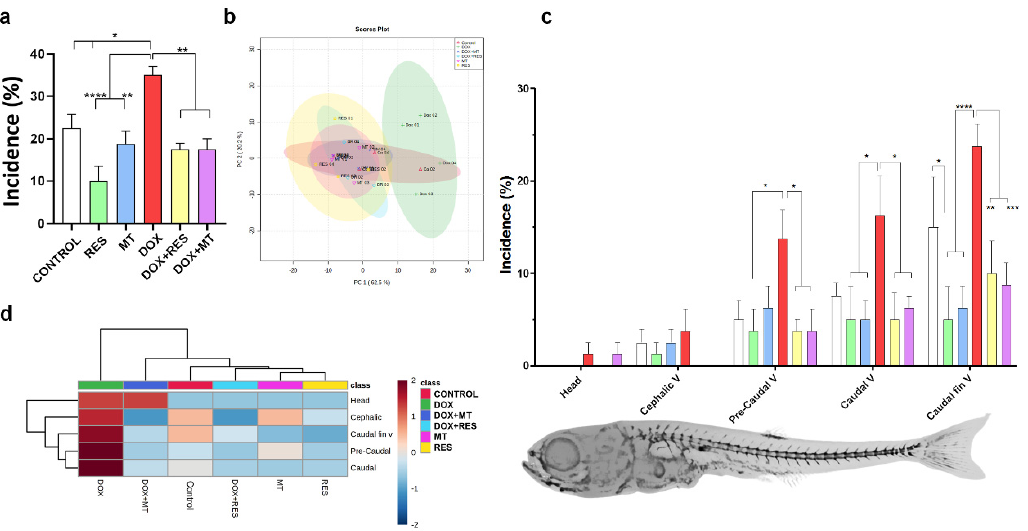
Figure 3. Incidence and distribution of skeletal deformities. Incidence of skeletal deformities ( a ). Partial Least-Squares Discriminant Analysis (PLS-DA score) on the incidence of deformities of zebrafish supplemented with antioxidants, resveratrol (RES), MitoTEMPO (MT), and pro-oxidant, doxorubicin (DOX) ( b ). Distribution of skeletal deformities ( c ) and heatmap of distribution of skeletal deformities ( d ). Statistical significances were calculated using Tukey’s multiple comparisons (one-way ANOVA) [* p ≤ 0.05, ** p ≤ 0.01, *** p ≤ 0.001, **** p ≤ 0.0001] [N = 20 × 4].